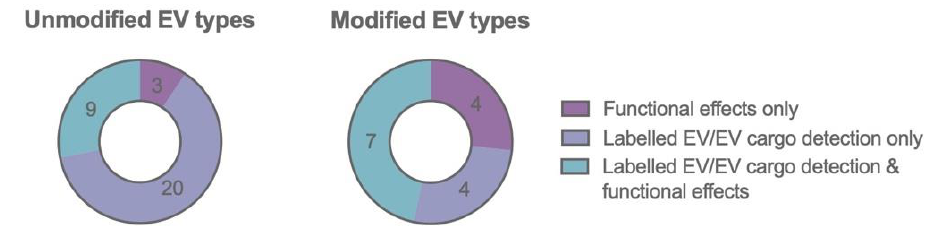
Figure 3. Overview of the brain targeting extracellular vesicle (EV) detection methods of the summarized literature (Tables 1 and 2). Pursuing the combination of both EV tracing and proof of functional cargo delivery will provide stronger evidence of EV brain targeting capacities.